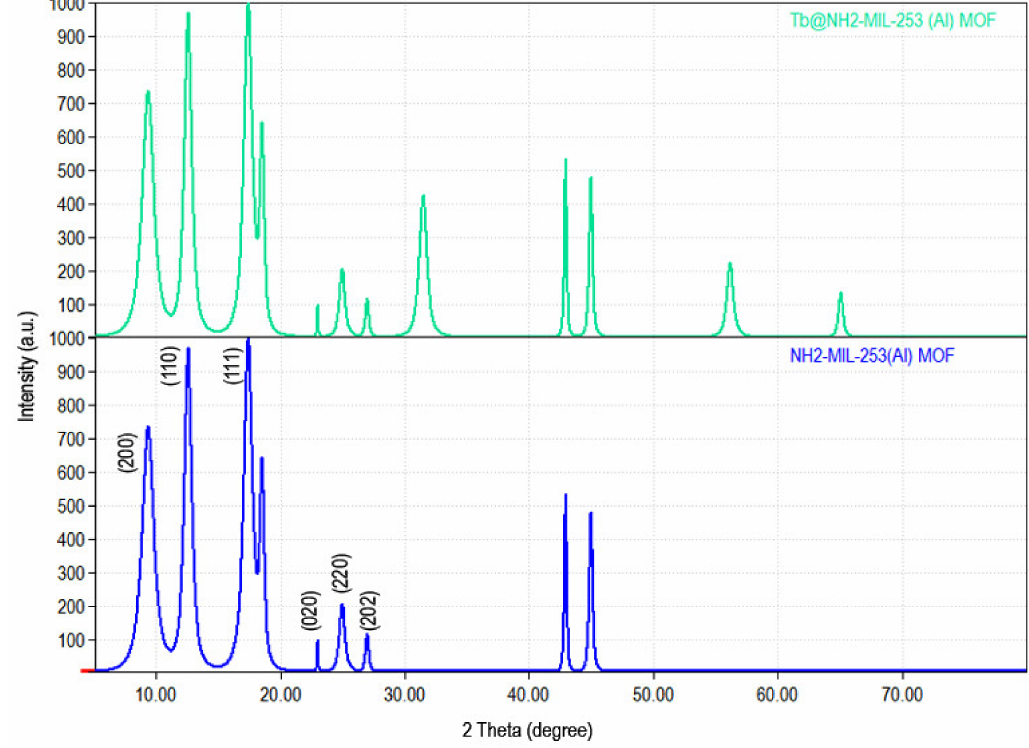
Figure 1. XRD patterns of Tb@NH 2 -MIL-253 (Al) MOF, and NH 2 -MIL-253 (Al) MOF fluoresc- ence